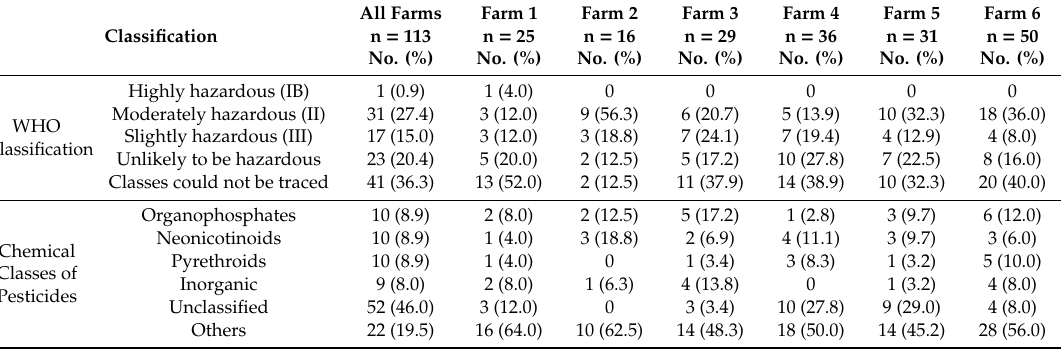
Table 4. Pesticide classification based on WHO acute hazard classification and the chemical composition of the pesticides’ active